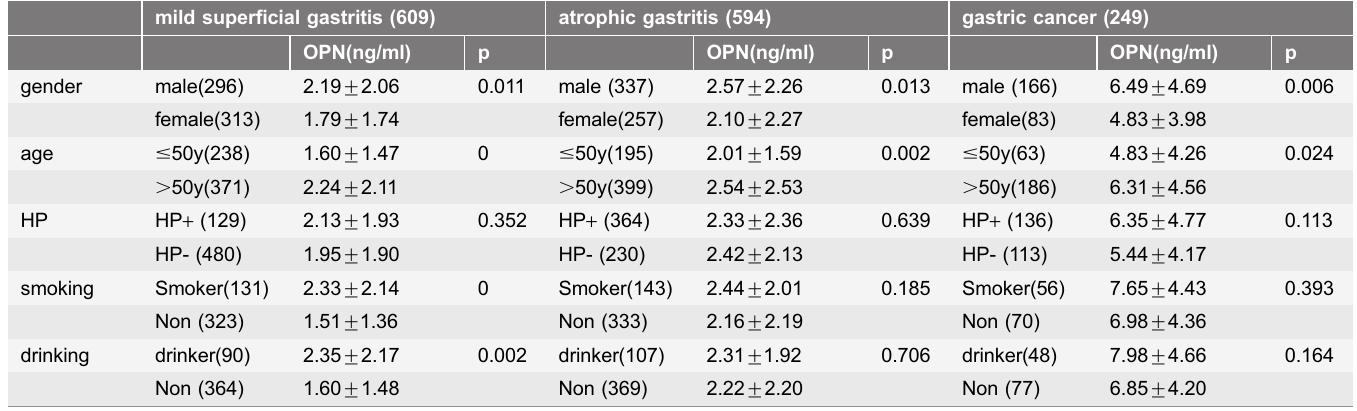
Table 4. Serum OPN expression in different gender, age, H. Pylori status, smoking and alcohol drinking. mild superficial gastritis (609) atrophic gastritis (594) gastric cancer